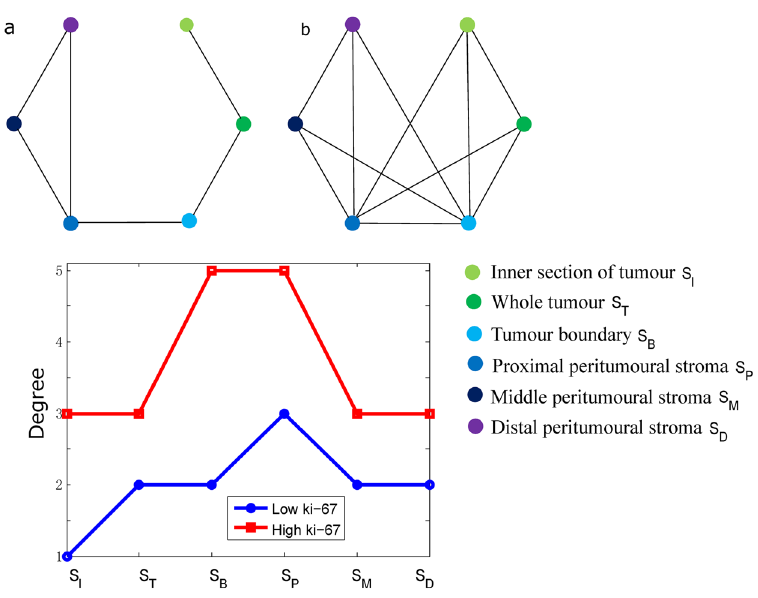
Figure 3. Connections between regions of tumours and peritumoural stroma. Graphs are shown for ( a ) low-Ki-67 and ( b ) high-Ki-67 groups. The degree for each region in the Ki-67 groups is shown in ( c ). Each node on the graph represents a tumour or peritumoural stroma, i.e., (1) inner section of a tumour, (2) whole tumour, (3) tumour boundary, (4) peritumoural stroma, (5) middle peritumoural stroma, and (6) distal peritumoural stroma. Each edge in this graph is defined by a significant correlation of mean ADC values between two regions (Bonferroni-corrected P value of Pearson’s correlation coefficient less than